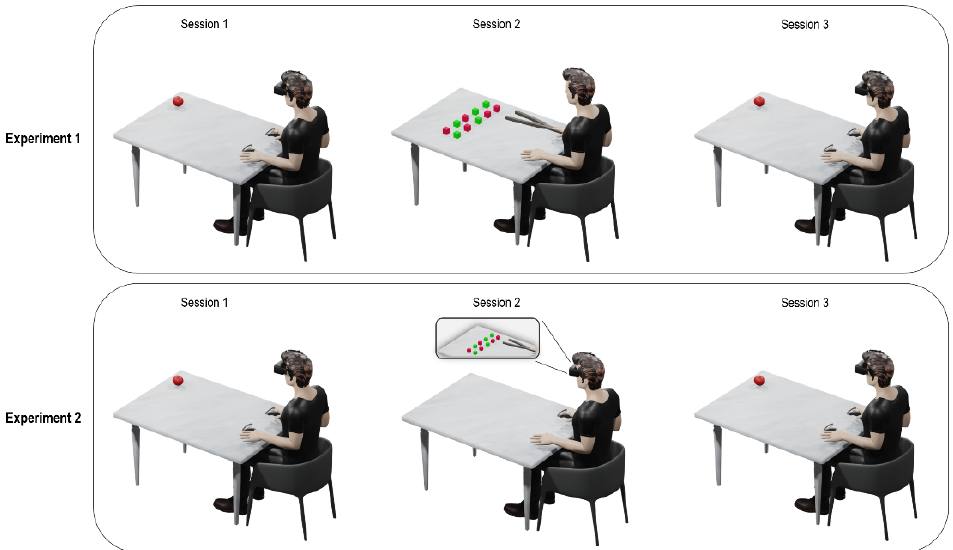
Figure 1. Graphical representation of the experimental procedure. For both experiments, Session 1 and Session 3 show the experimental setting of the visuo-tactile Peripersonal Space (PPS) task. Session 2 shows the qualitative representation of the training phase for both Experiments 1 and 2.